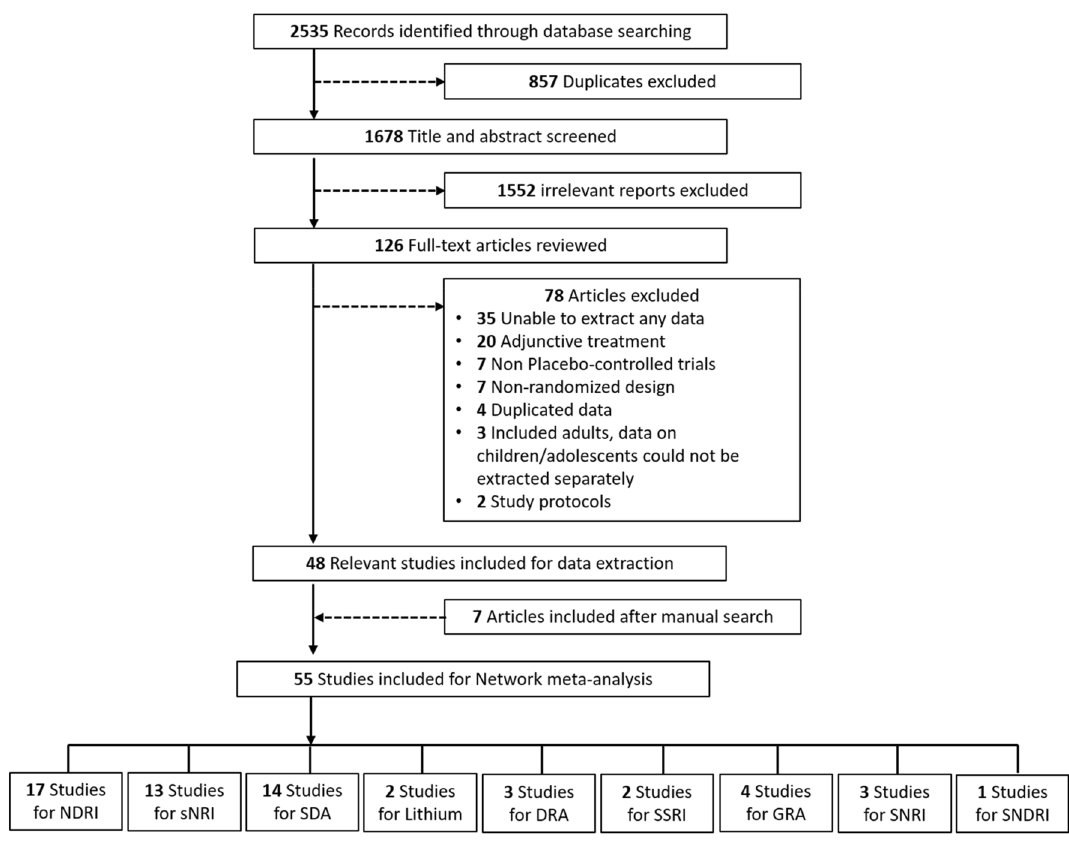
Figure 1. Flow diagram of study